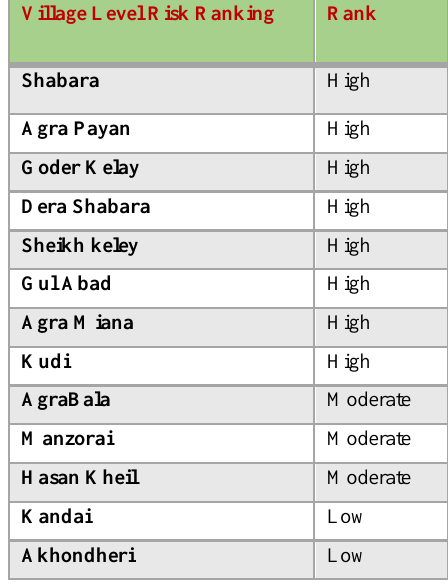
Table 2. Risk based ranking of villages in UC Agra Total roads in the study area were 75 kilometers in which 15 kilometers roads are at risk to 10 years return period, 43 kilometers to 30 years return period and 67 kilometers are at high risk 100 years flood return period. The total hand pumps in the study area were 2398 in which 911 hand pumps are at risk to 30 years return period and 1774 are at high risk to 100 years return period however the contamination of underground water issue remains the same for all hand pumps. Total latrines in the study area were 3205 in which 1,217 are at risk to 30 years return period and 2,315 are at risk to 100 years flood return